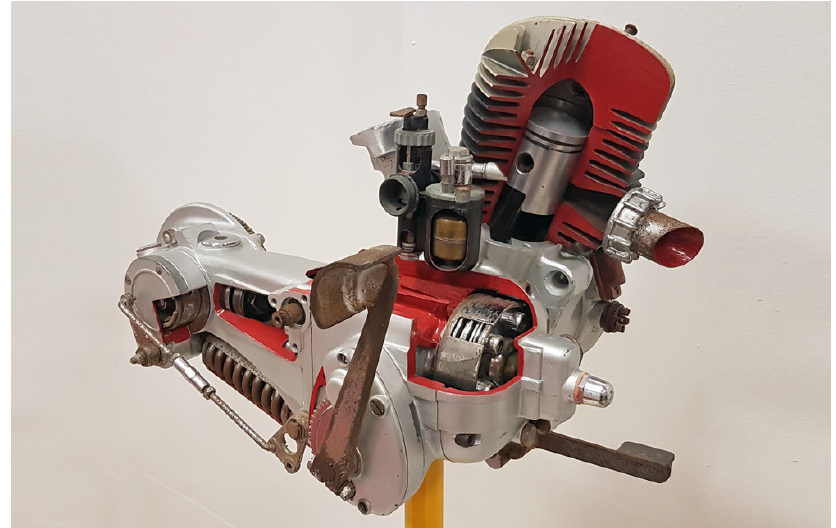
Figure 5. Engine of the Innocenti motorcycle, Lambretta 125 C (1950–1951) at the Museum of Engines and Mechanisms, University of Palermo.